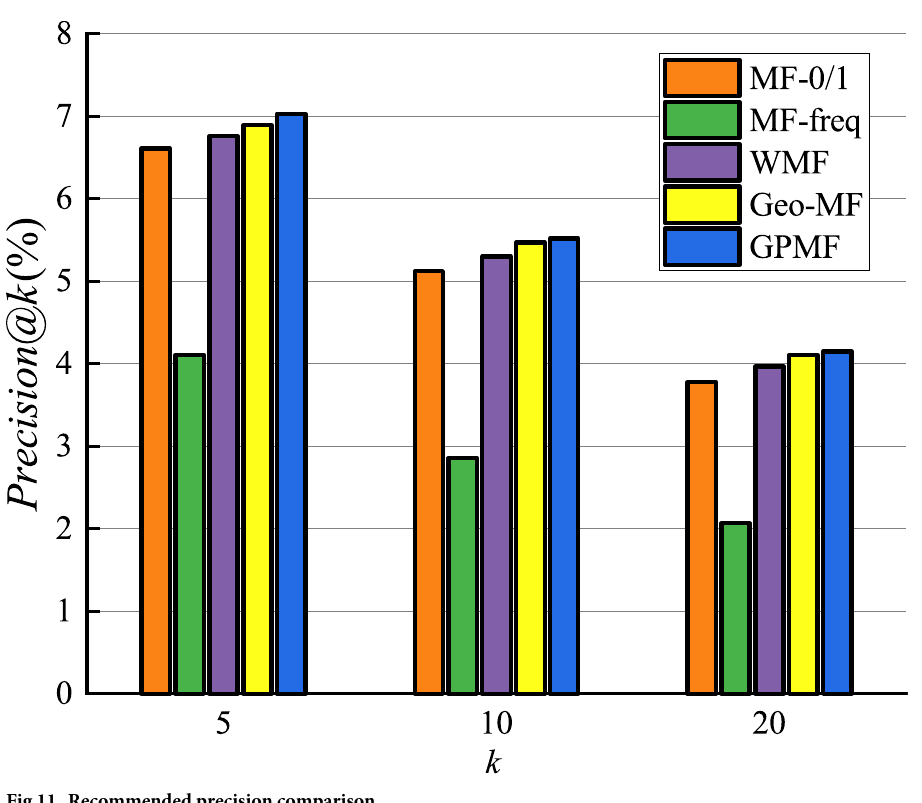
Fig 11. Recommended precision